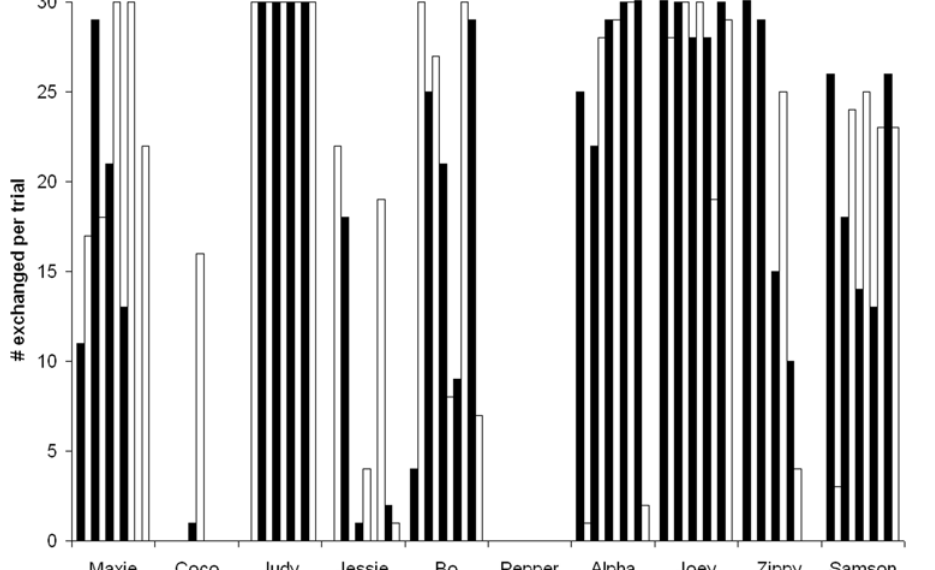
Figure 2. The number of exchanges by each subject at Bastrop in each of the 10 sessions in which they could exchange a piece of cucumber for a grape (30 exchanges were possible for each session). The number of exchanges was highly variable, both between subjects and between sessions within individuals. Sessions are presented in chronological order for each subject (indicated by their name), with black bars indicating odd sessions and white bars indicating even sessions.